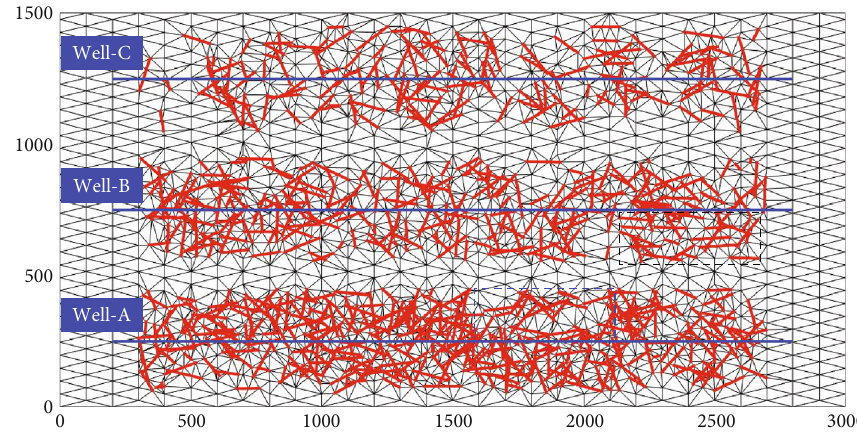
Figure 14: A large-scale densely fractured model containing three long horizontal